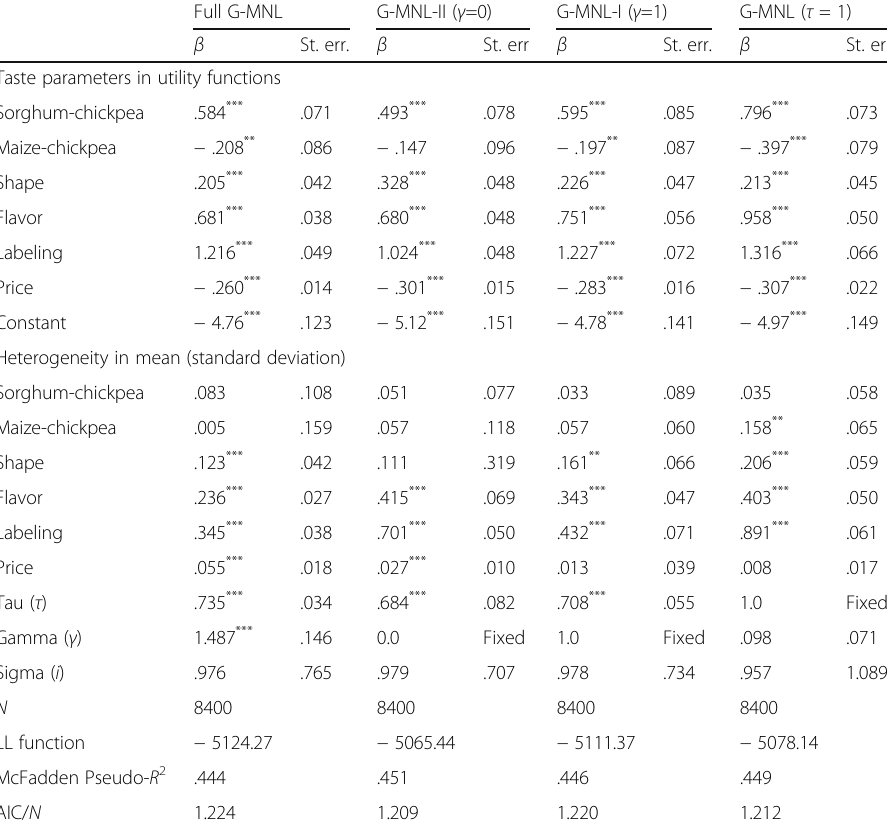
Table 5 Basic G-MNL model results of attributes ’ choice